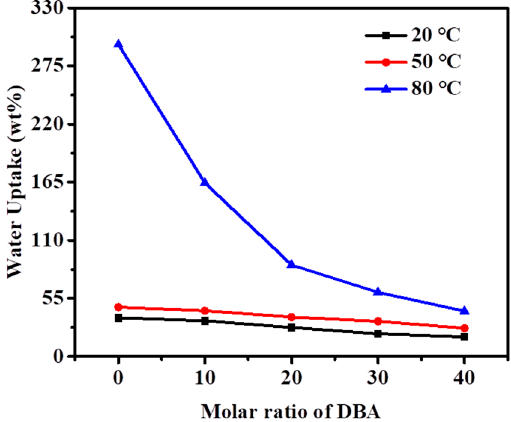
Figure 7. The water uptake of CSPEN-60-DBA-x at different temperatures.